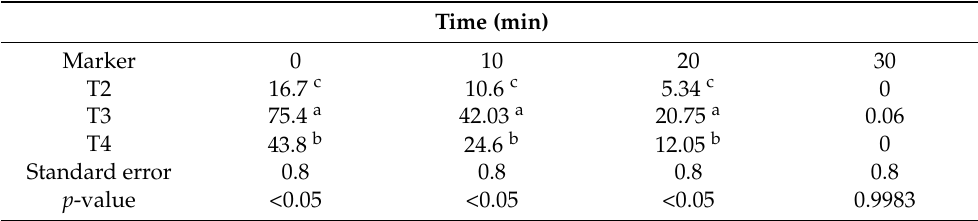
Table 3. Transit time (min) of the different markers in Artemia .